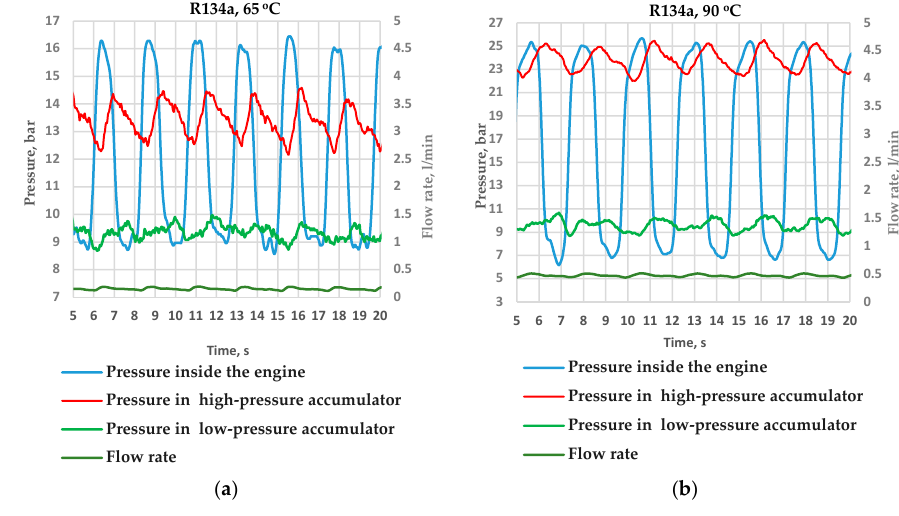
Figure 6. Examples of pressure change and pumped flow rate in the self-driven Bush-type engine; working fluid: R134a; temperature of the cooler: 25 °C; temperature of the heater: 65°C ( a ) and 90°C ( b ).